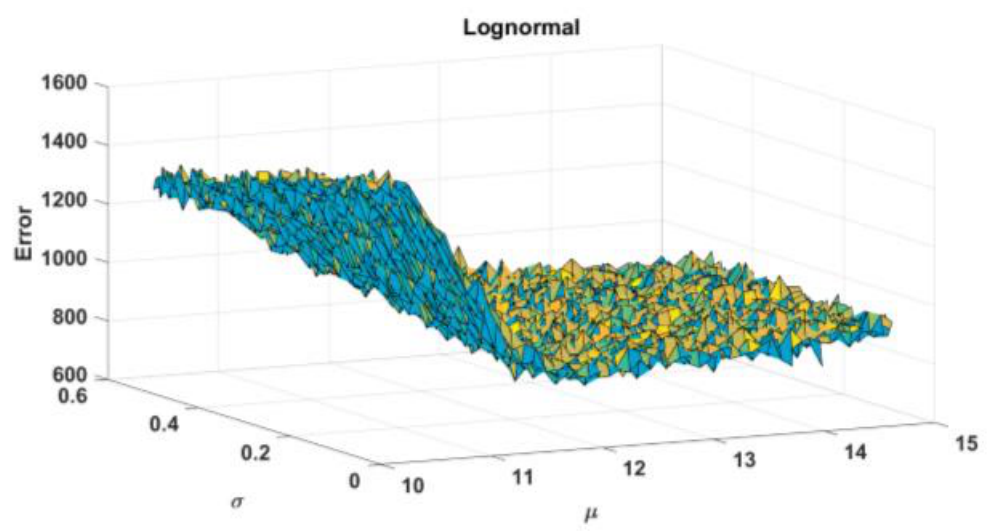
Figure 18. Validation error (Lognormal): Error—error value, σ —sample dispersion, µ —sample expectation value.